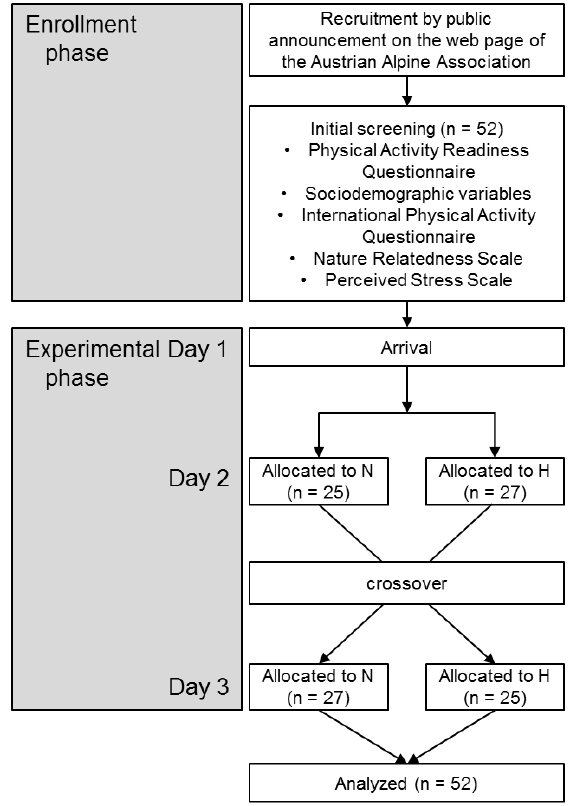
Figure 1. Flow diagram for data collection. N: Hiking in an environment with less anthropogenic elements, H: Hiking in an environment with more anthropogenic elements.